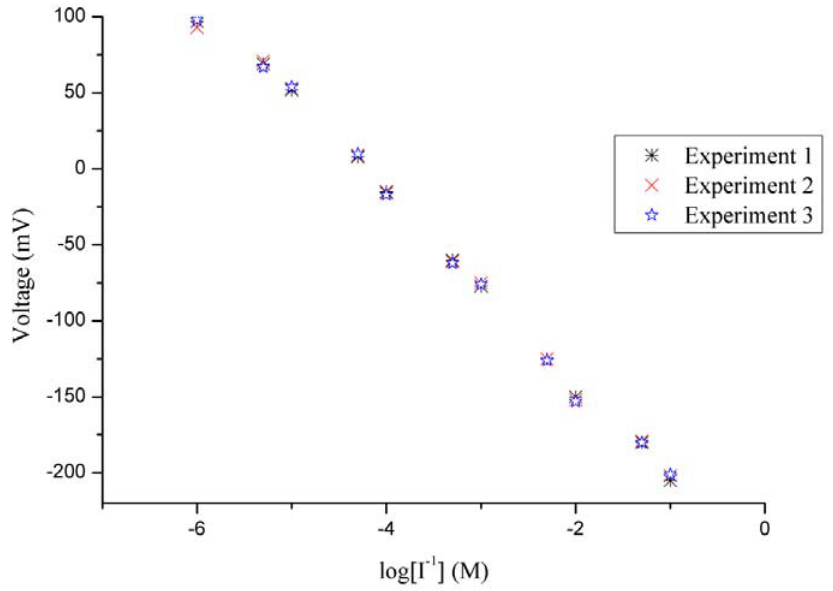
Figure 7. The repeatability calibration curve of the iodide ion sensor.